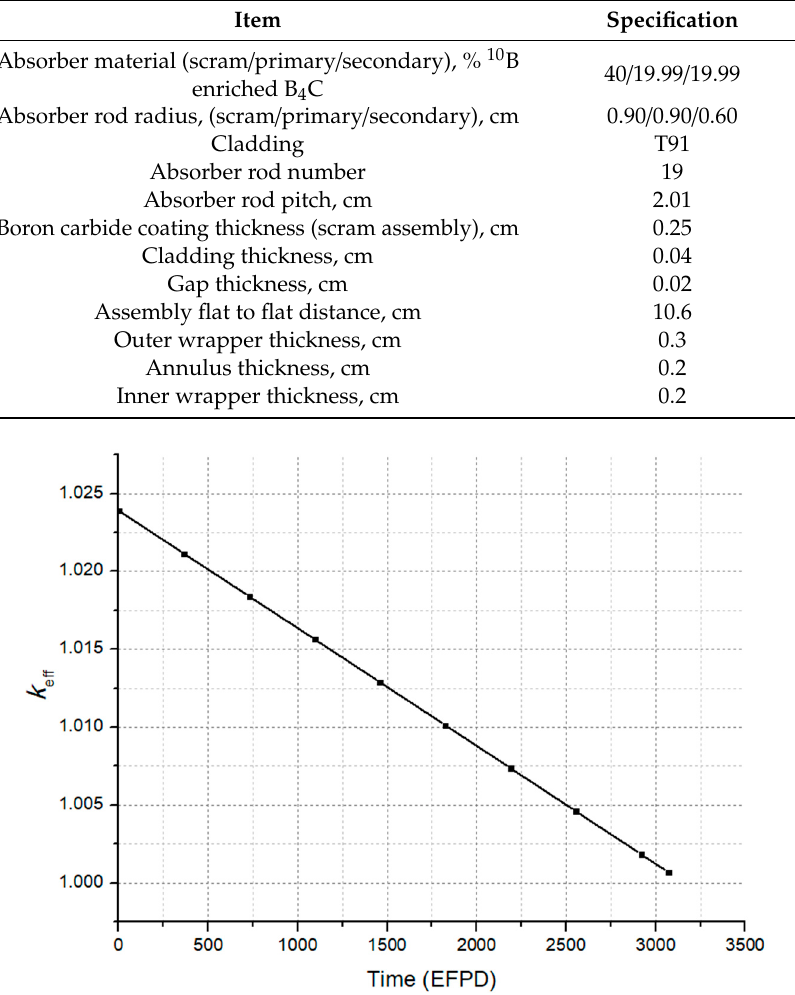
Figure 5. Evolution of k eff with time for the reactor core design.